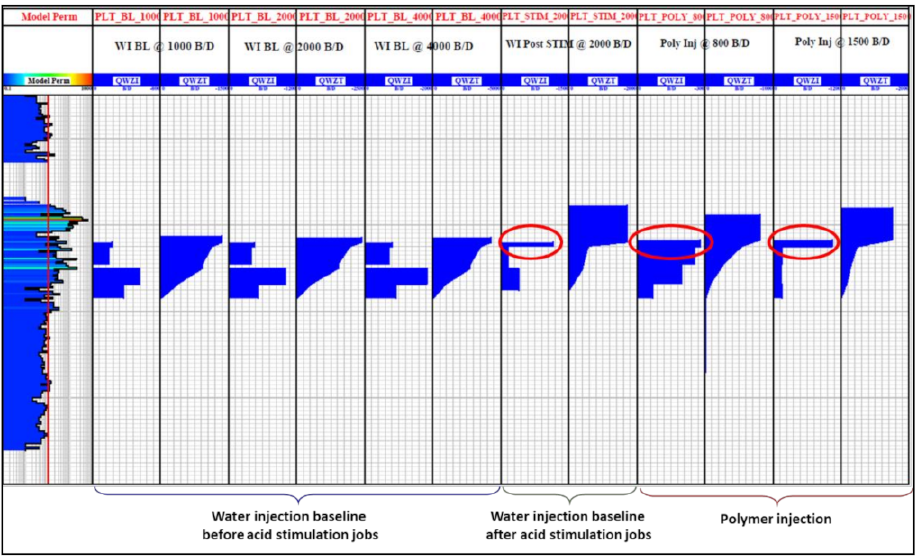
Figure 8. Production logging tool (PLT) logs conducted during injectivity test (Modified from [20]).